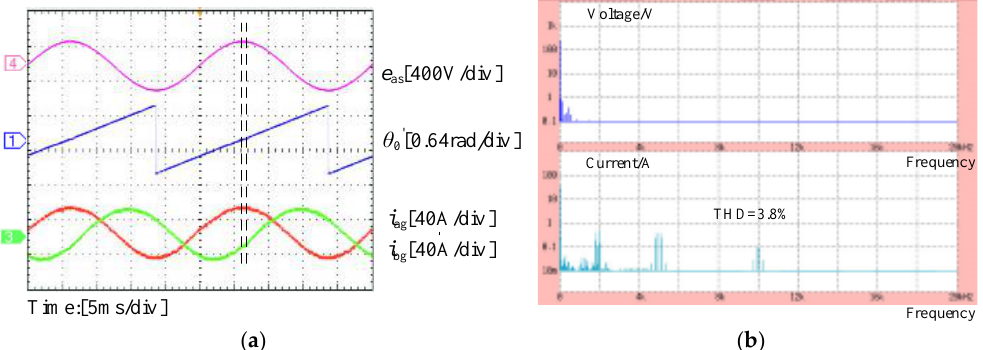
Figure 13. The experimental results when the inverter is connected with the grid. ( a ) The voltage and current waveforms. ( b ) The harmonic spectrum of the voltage and current.